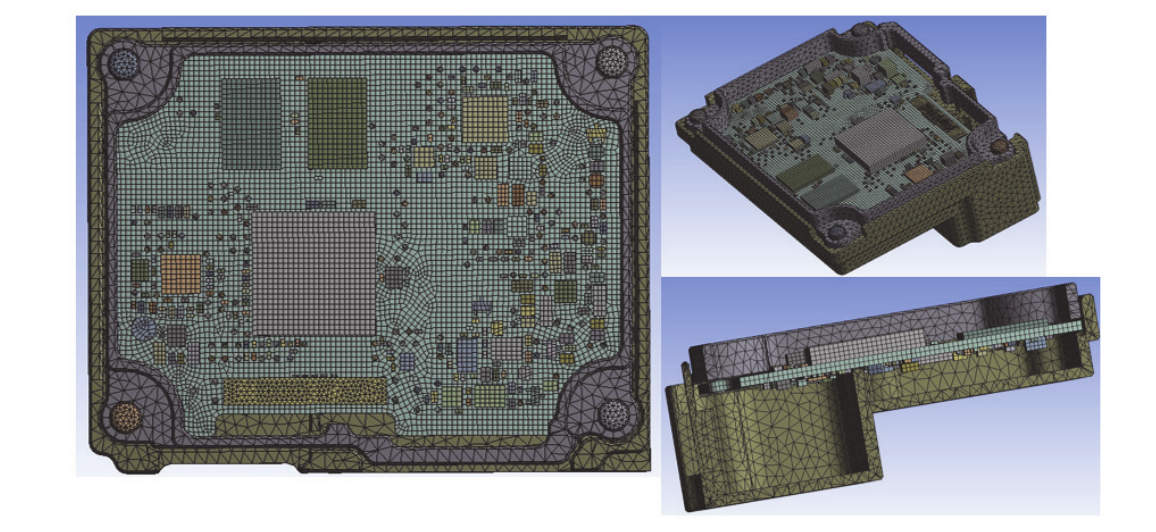
Figure 5: Finite Element Mesh.